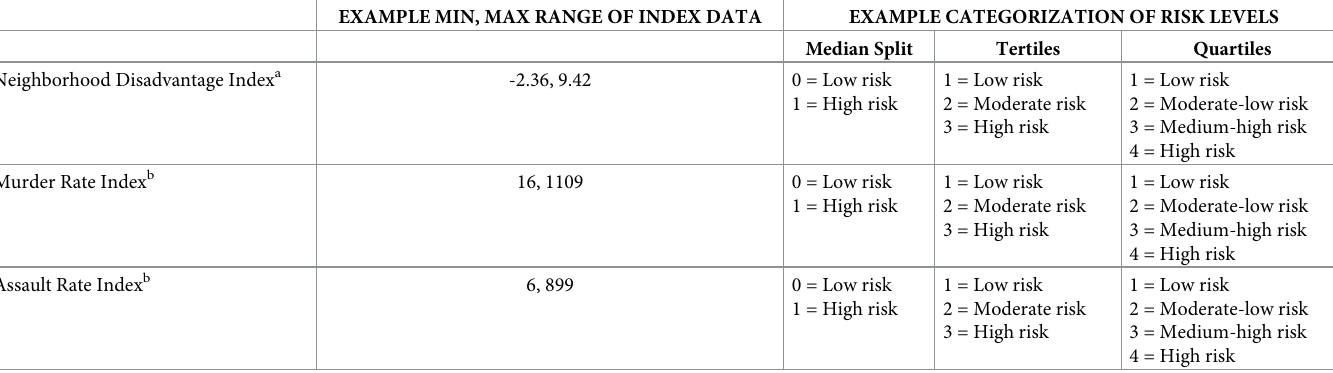
Table 1. Resulting indices of the neighborhood risk environment in example multisite